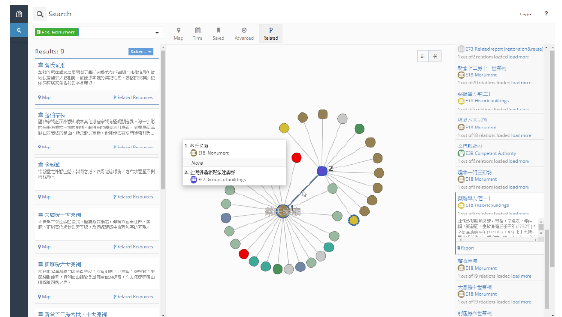
Figure 12. Association diagram of related resources of Yi Gu